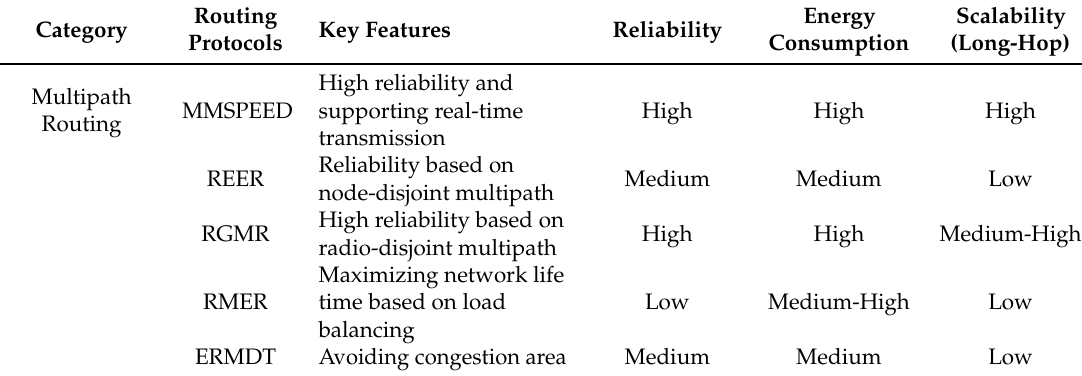
Reliable routing protocols based on multipath routing, opportunistic routing, and a learning-based